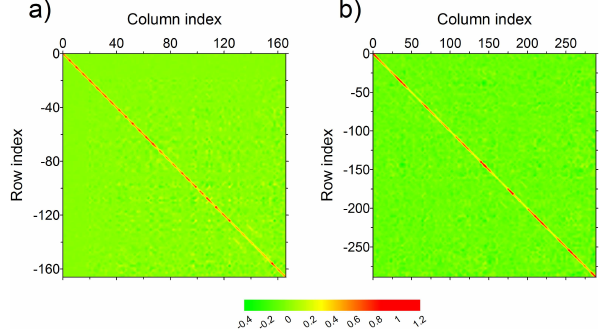
Fig. 3. The model resolution matrix R m computed considering the discretization of the matrix A : (a) cells of 40m × 40m × 10m; (b) cells of 20m × 20m × 5m.